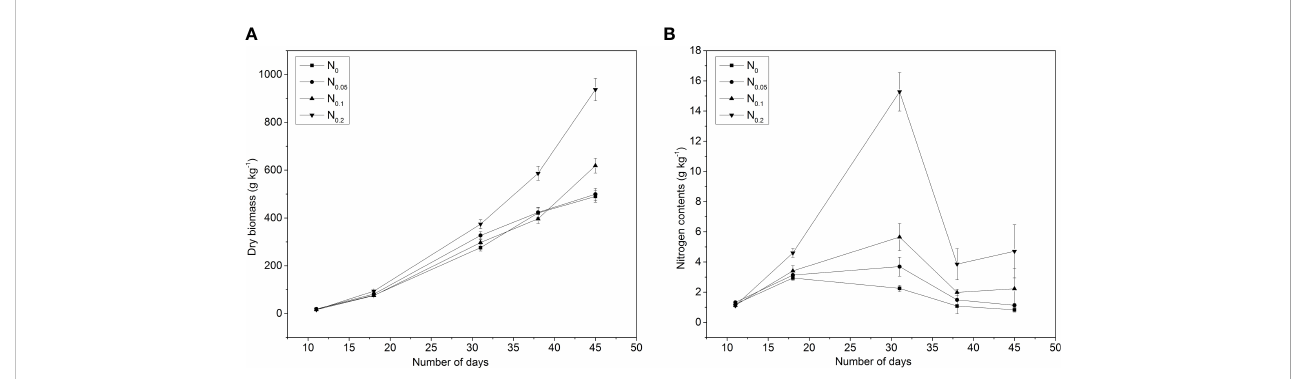
FIGURE 1 Effects of nitrogen (N) application on (A) plant dry biomass (DW) and (B) N contents under different intervals of time in pakchoi (Experiment 1). N 0 = 0 g N kg -1 soil,